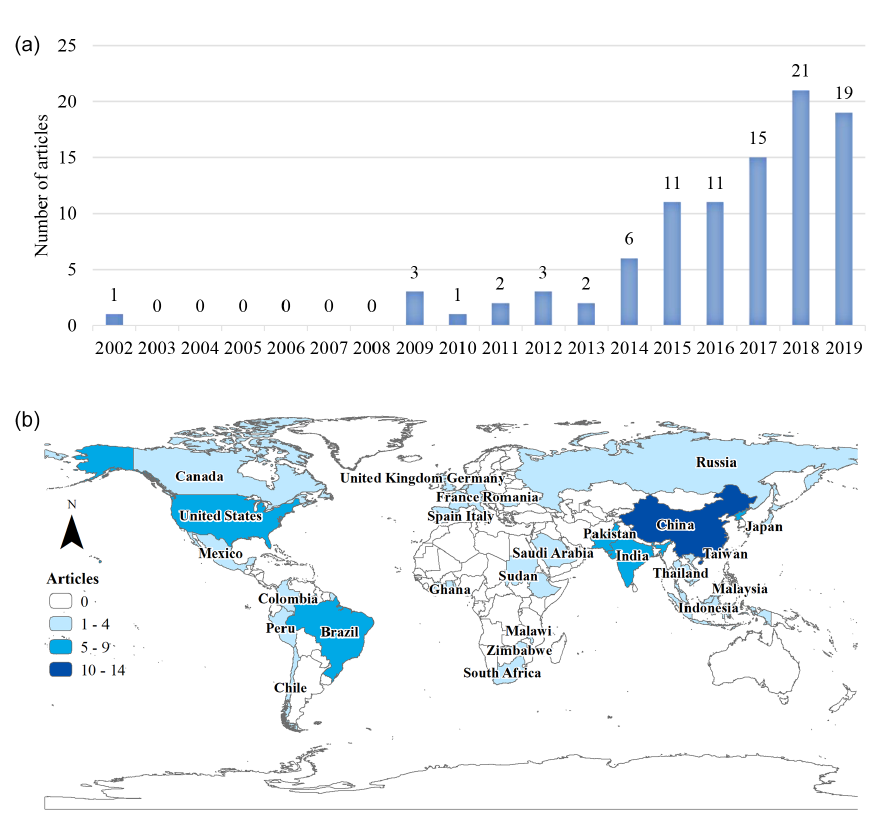
Figure 2. Flood vulnerability index studies. (a) Temporal distribution from 2002 to 2019. For the standardized number of articles according to the total number of publications in the WoS database, see Appendix A (Fig. A1). (b) Geographical